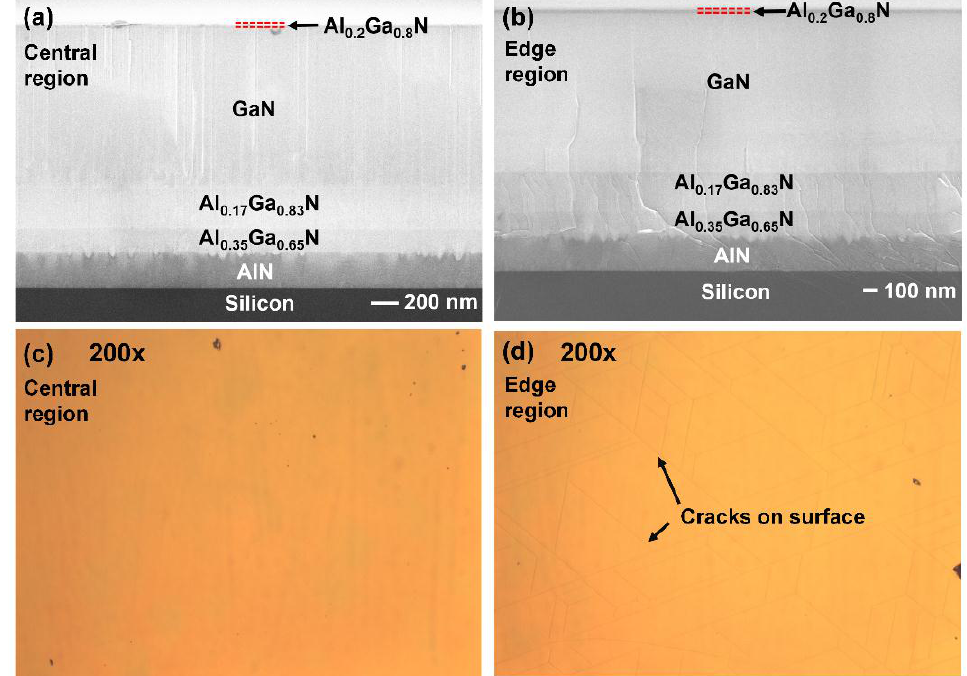
Figure 2. Cross-sectional SEM images of the epi-structure of GaN HEMT on silicon ( a ) in the central region and ( b ) in the edge region; Optical microscope images of the wafer surface ( c ) in the central region and ( d ) in the edge region.